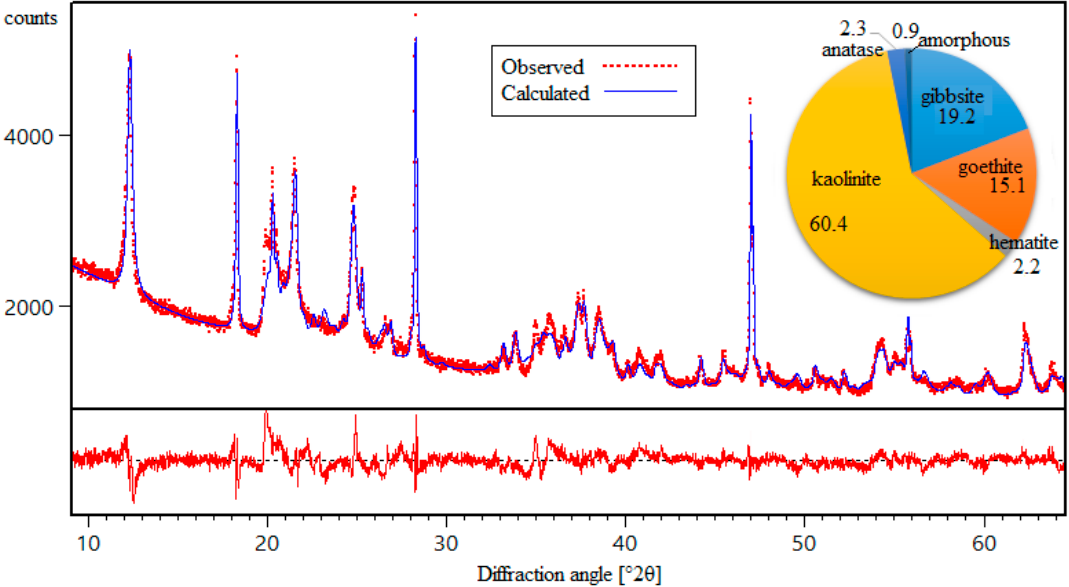
Figure 5. Refined X-ray pattern of sample CIR14m and its difference plot using Highscore Plus. Goodness of fit: 1.6 and R—weighted profile: 5.5.